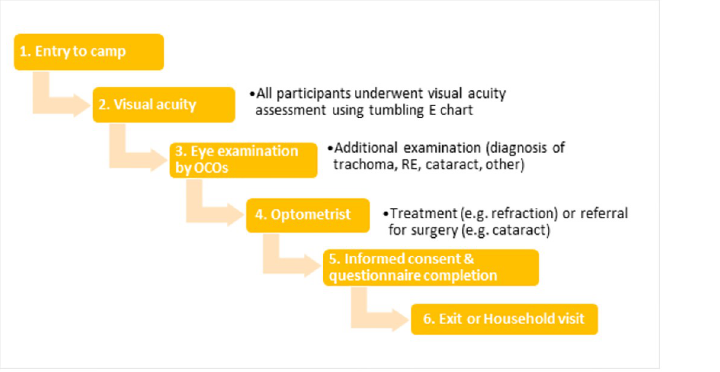
Fig 2. Flow diagram of outreach camp